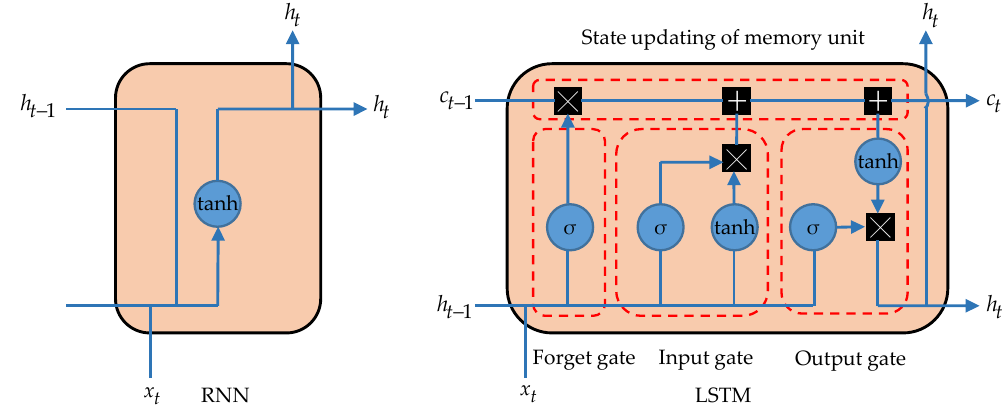
Figure 2. Architecture of RNNs and LSTM.